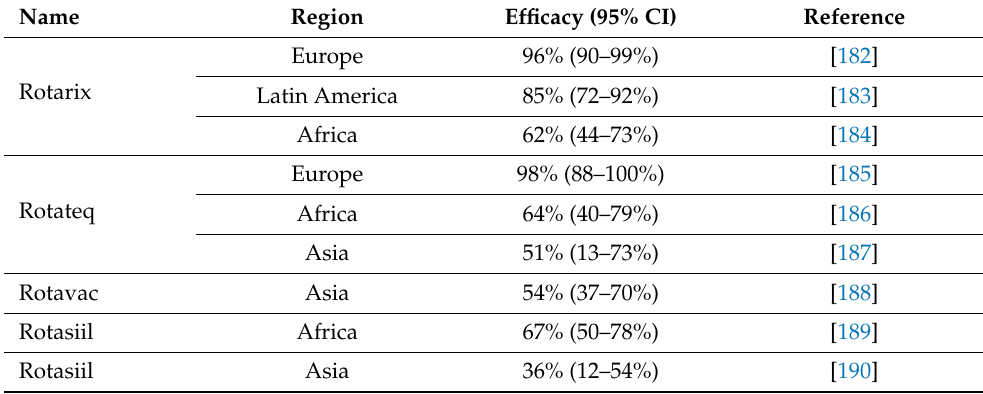
Table 3. Efficacy data for globally licensed rotavirus vaccines.